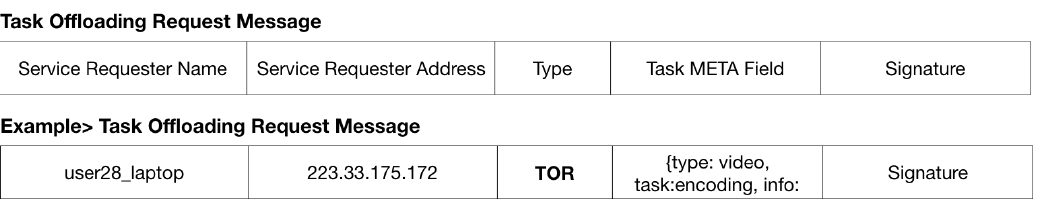
Figure 6. The task offloading request (TOR) message format and